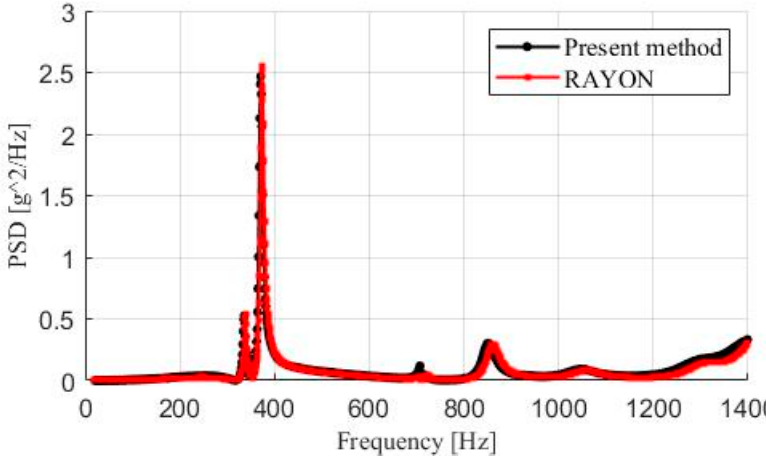
Figure 13. Power spectral density at node P2X (0.3, 0.208) for rectangular plate immersed in diffuse field.